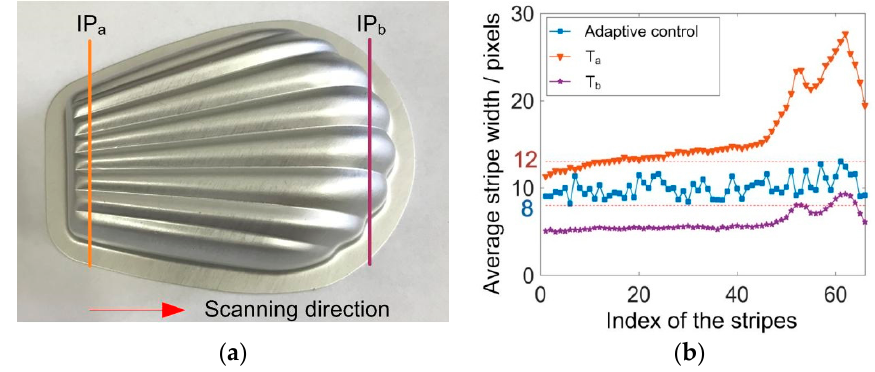
Figure 13. Measurement of a metal part. ( a ) The part and the specific intersection profiles; ( b ) the change of average stripe width during the scanning process.